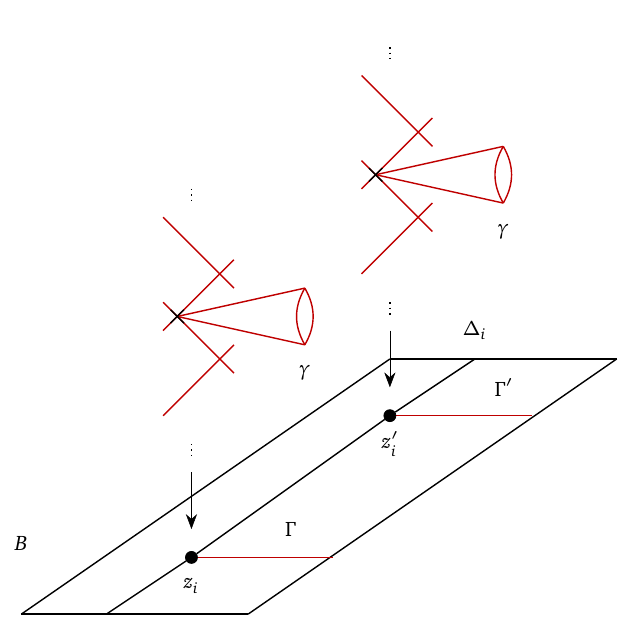
( γ , z } ) and , { C Γ i k i ( γ ) . i